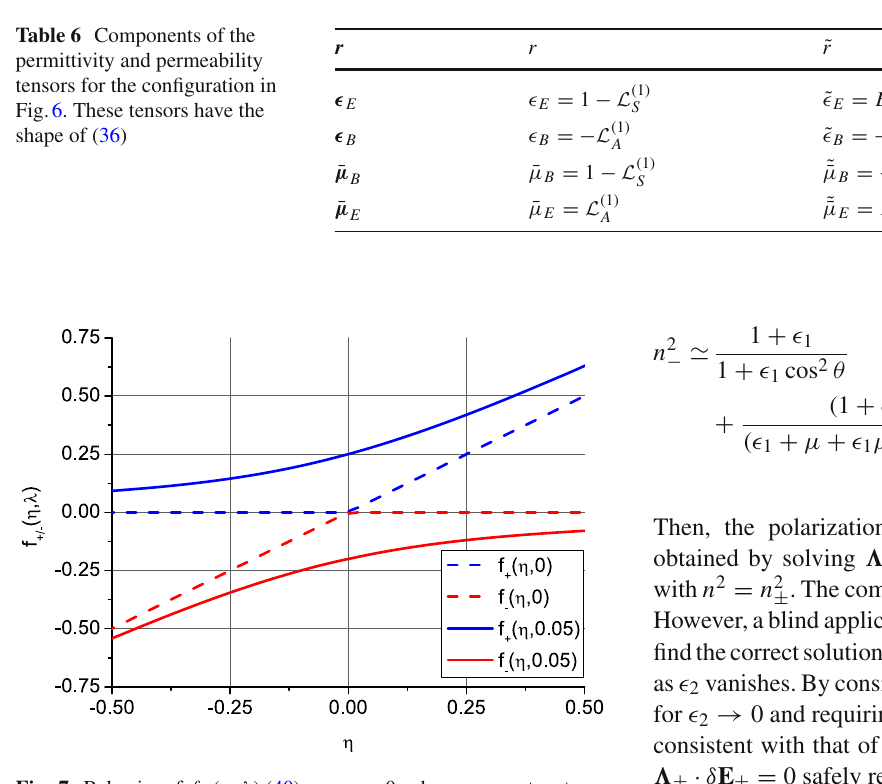
Fig. 7 Behavior of f ± (η,λ) (40) near η = 0, where η = (cid:15) 1 + μ + (cid:15) 1 μ and λ = (cid:15) 2